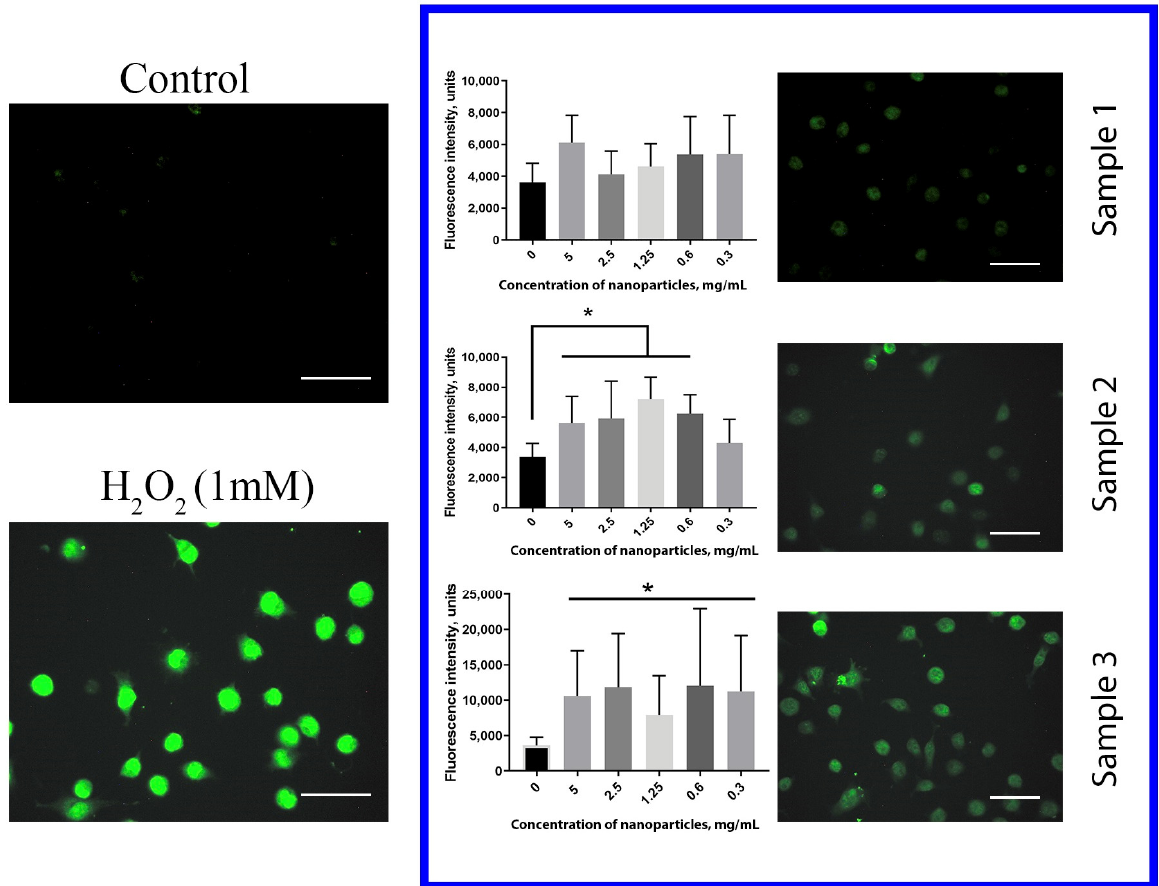
Figure 7. ROS-level assessment after 24 h of incubation with Ce 0.8 Gd 0.2 O 2 − x nanoparticles; hMSc were labelled with DCF (40 µ M) and incubated for 30 min. Cells were analysed using a fluorescent plate reader (Tecan Infinity 200). Mean +/ − standard deviation (SD) is plotted for five replicates. * p < 0.05. Scale bar is 100 µ m.